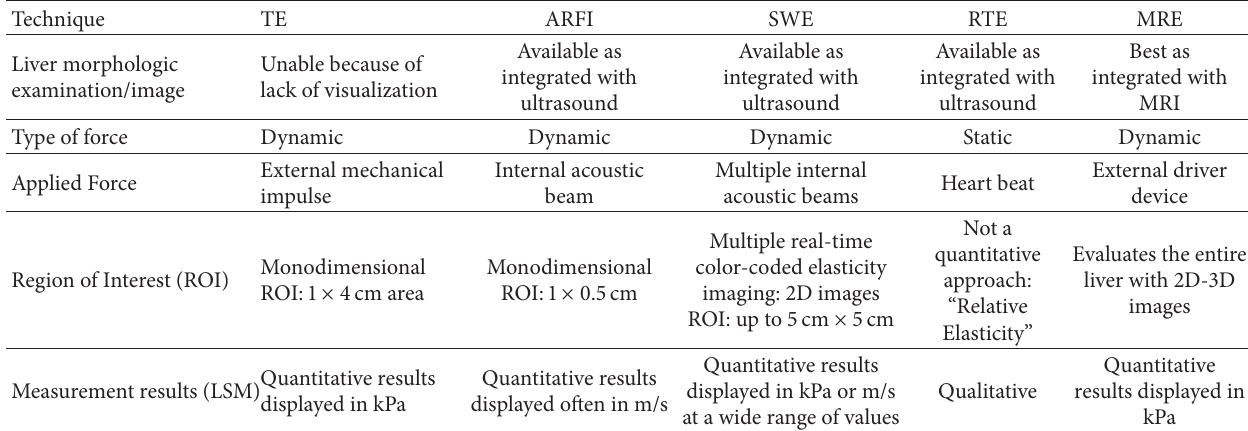
Table 1: Salient features of technical aspects of liver elastography